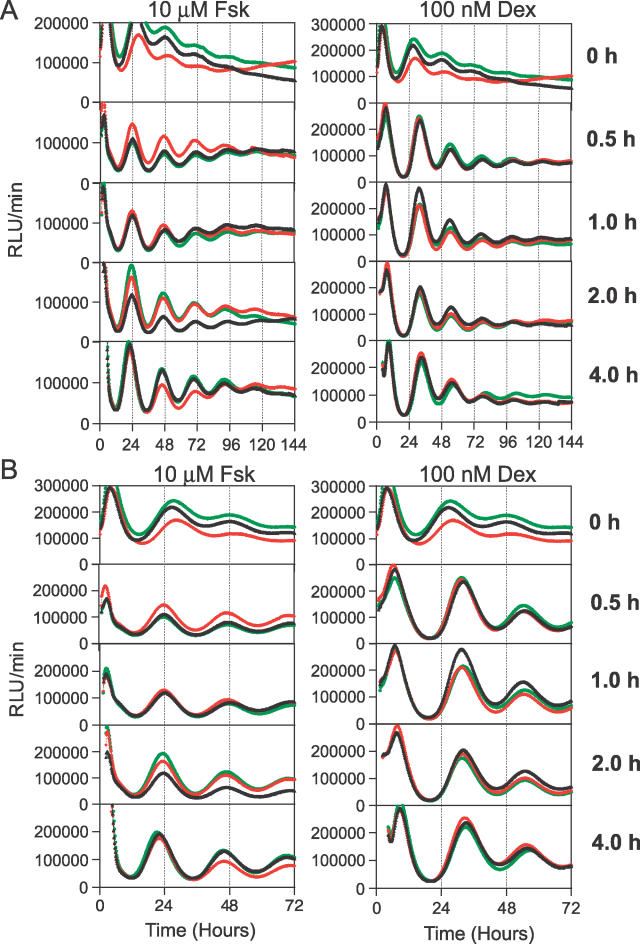
Time-Dependent Stimulation Effect of Two Drugs on the Initiation of Rhythmicity in Rat-1/Pmper2::dLuc Reporter CellsRat-1/Pmper2::dLuc reporter cells were treated with either 10 μM Fsk or 100 nM Dex for the indicated period of time before monitoring luminescence rhythms. 0 h indicates no drug treatment (only a medium change). Time 0 is the onset of stimulation. Three replicates from a larger data set of the same treatments are shown in each graph (total N = 6).(A) Bioluminescence traces of 6 d of continuous measurements. Left panel, 10 μM Fsk; right panel, 100 nM Dex. The graph for the “0 h” control data is repeated with different ordinal scales for the Fsk and Dex columns to aid visualization (the ordinal scale is expanded for the Fsk column).(B) Figure 6A is rescaled to show the first 3 d. The scale for the ordinate is held constant in this panel.